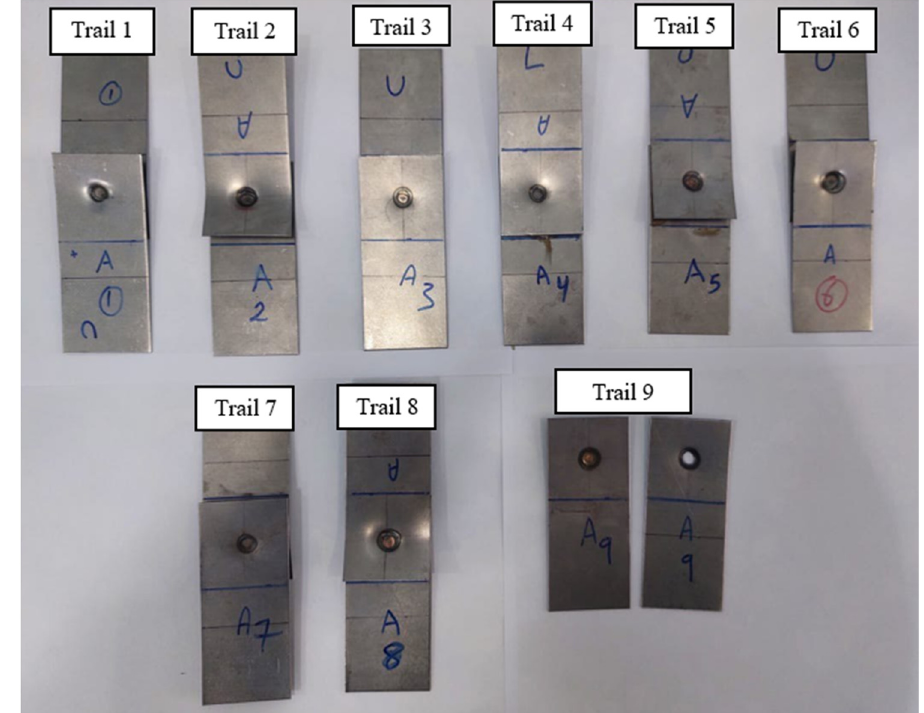
Figure 17: Welded specimens after tensile shear